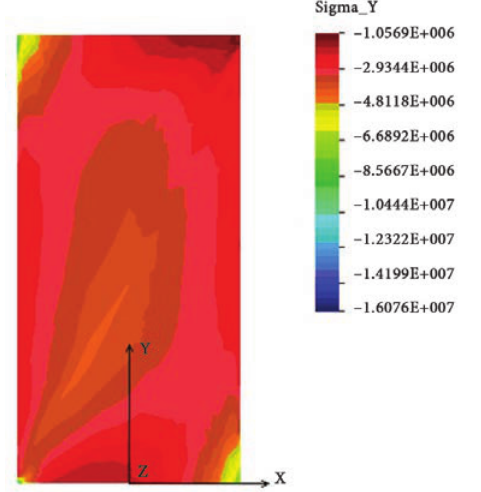
Fig. 9. Distribution of vertical component of stress s y in the sample with fixed end